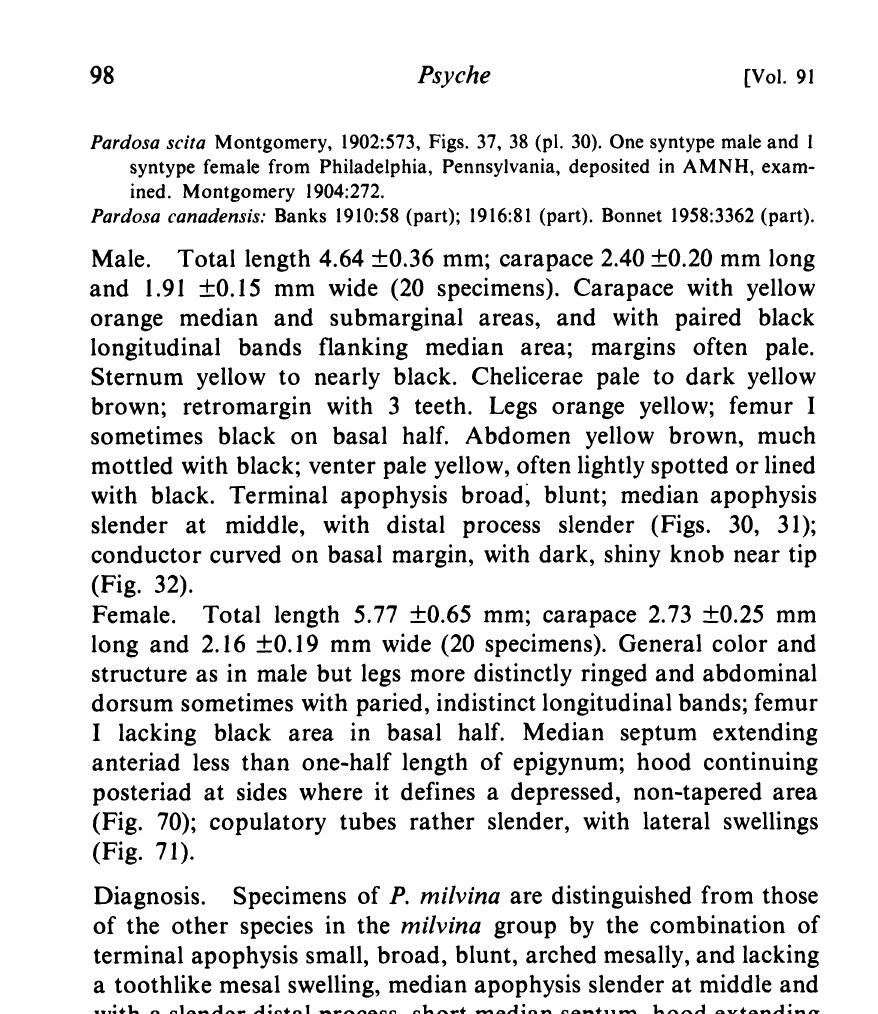
Pardosa scita Montgomery, 1902:573, Figs. 37, 38 (pl. 30). One syntype male and syntype female from Philadelphia, Pennsylvania, deposited in AMNH, exam- ined. Montgomery